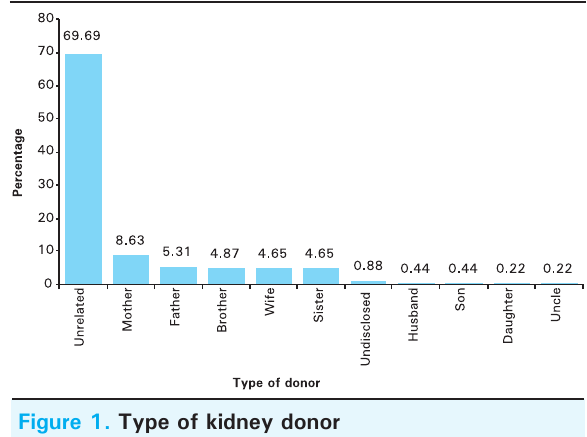
Figure 1. Type of kidney donor Kidney recipients were from various ethnic groups, highest being Newar 142 (31.4%) and second largest group was Mangol 124 (27.4.4%) that comprised of Gurung, Rai, Magar, Tamang etc. Brahmins 91 (20.1%) were the third largest population (Table